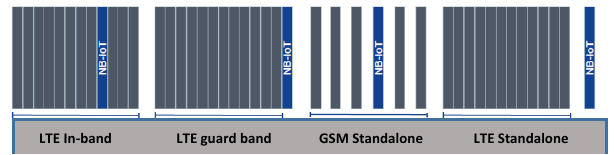
Figure 8: Deployment Scenarios of